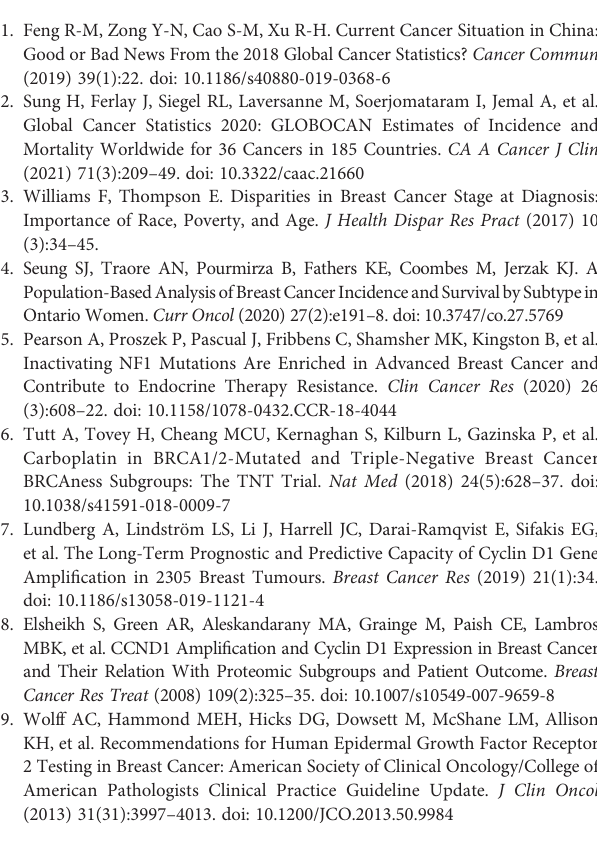
Supplementary Figure 1 | Cancer distribution in the family members of patients with breast cancer. (A) Relative proportion of patients with breast cancer whose family members have any type of cancer is indicated with the bin sizes. (B) The percentage of patients with breast cancer whose family members have any type of cancer is sorted along the x-axis.